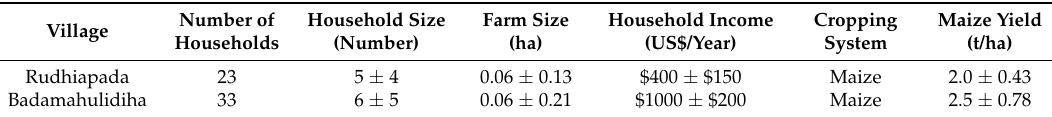
Table 1. Average smallholder farm household characteristics of the tribal villages Rudhiapada and Badamahulidiha in Kendujhar, Odisha, India. Number of Household Size Farm Size Household Income Cropping Maize Yield Village Households (Number) (ha) (US$/Year) System (t/ha)